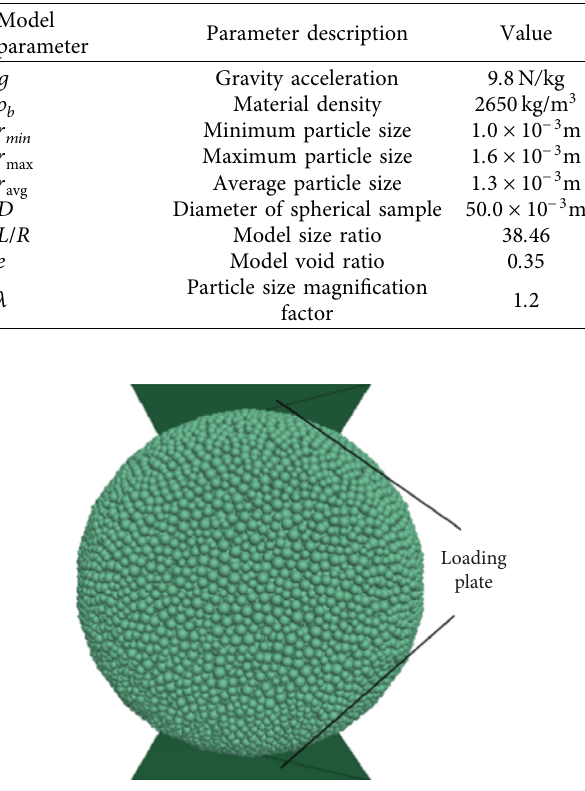
Table 3: Formation parameters of spherical numerical sample.